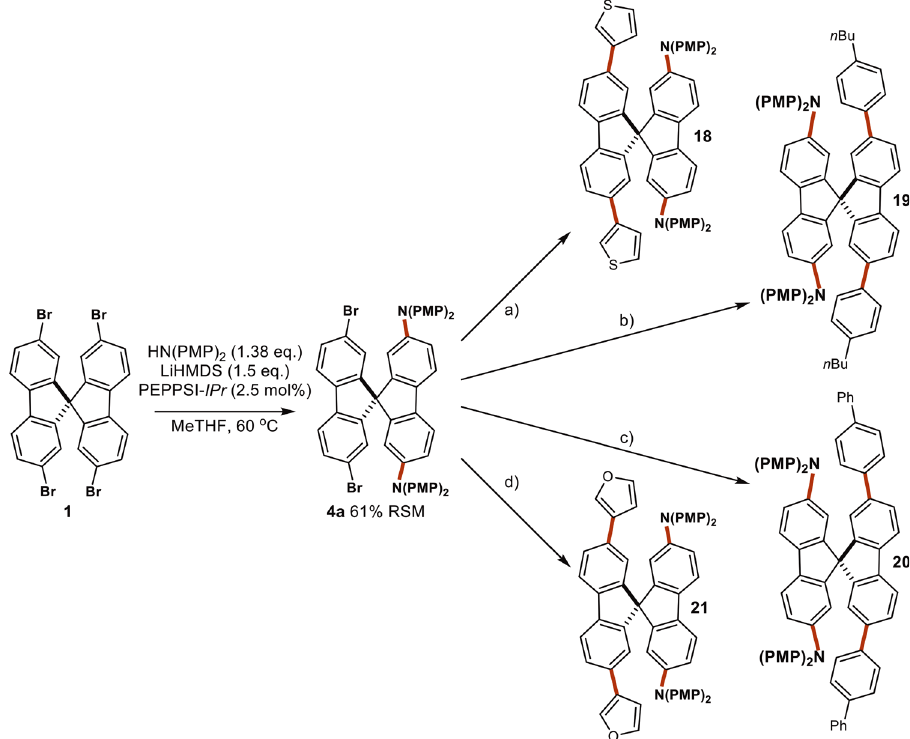
Fig. 10 Synthesis and derivatization of asymmetric SpiroOMeTAD derivatives. Desymmetrization of 1 conditions: 1 (0.40 mmol), HN(PMP) 2 (0.55 mmol), LiHMDS (0.60 mmol), PEPPSI-IPr (2.5 mol%), MeTHF (0.04 M), 60 °C, 3 h. Conditions ( a – d ) 4a (0.30 mmol), K 3 PO 4 (8.0 equiv), Water:THF 1:4 (0.075 M), 50 °C, 16 h. a 4.0 equiv. 3-thienylboronic acid. b 4.0 equiv. 4-butylphenylboronic acid. c 4.0 equiv. 4-biphenylboronic acid. d 4.0 equiv. 3-furanylboronic